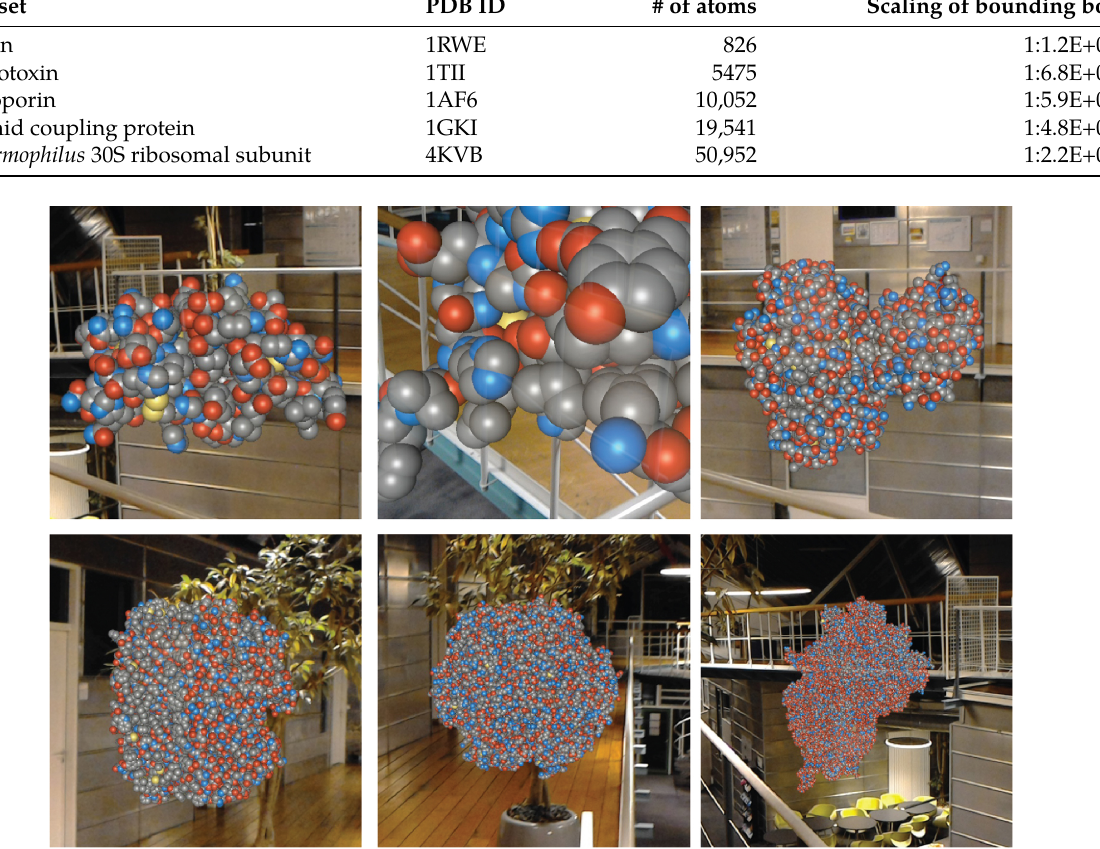
Figure 4: Live captures from our standalone UWP application rendering the data sets used in our benchmarks using raycasting on instances sprites. Upper row: 1RWE (826 atoms), close-up of 1RWE, 1TII (5475 atoms). Lower row: 1AF6 (10,052 atoms), 1GKI (19,541 atoms), 4KVB (50,952 atoms).